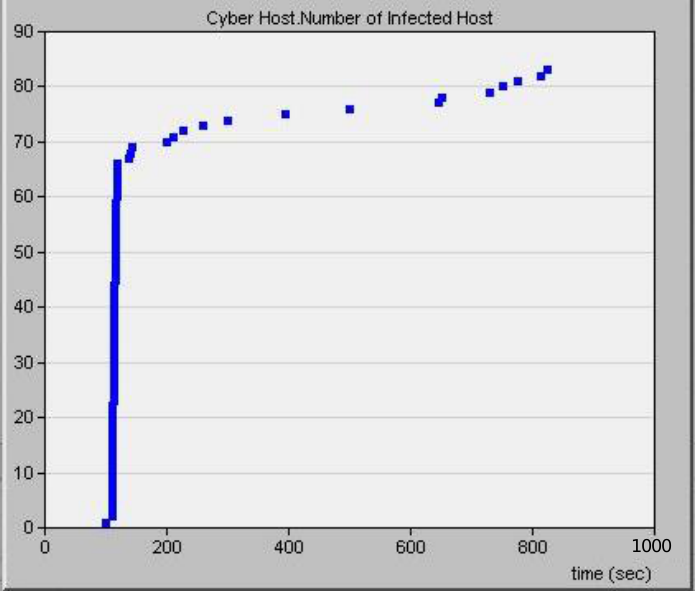
Figure 14. Number of devices participating in a cyberattack according to simulation time.